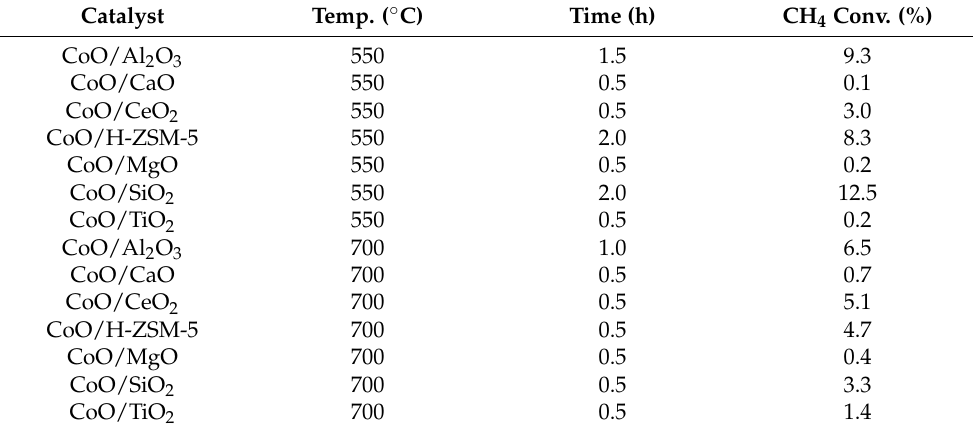
Table 13. Catalytic performance of cobalt-based catalysts prepared via impregnation method with the same Co loading (10 wt.%) but supported on various types of materials